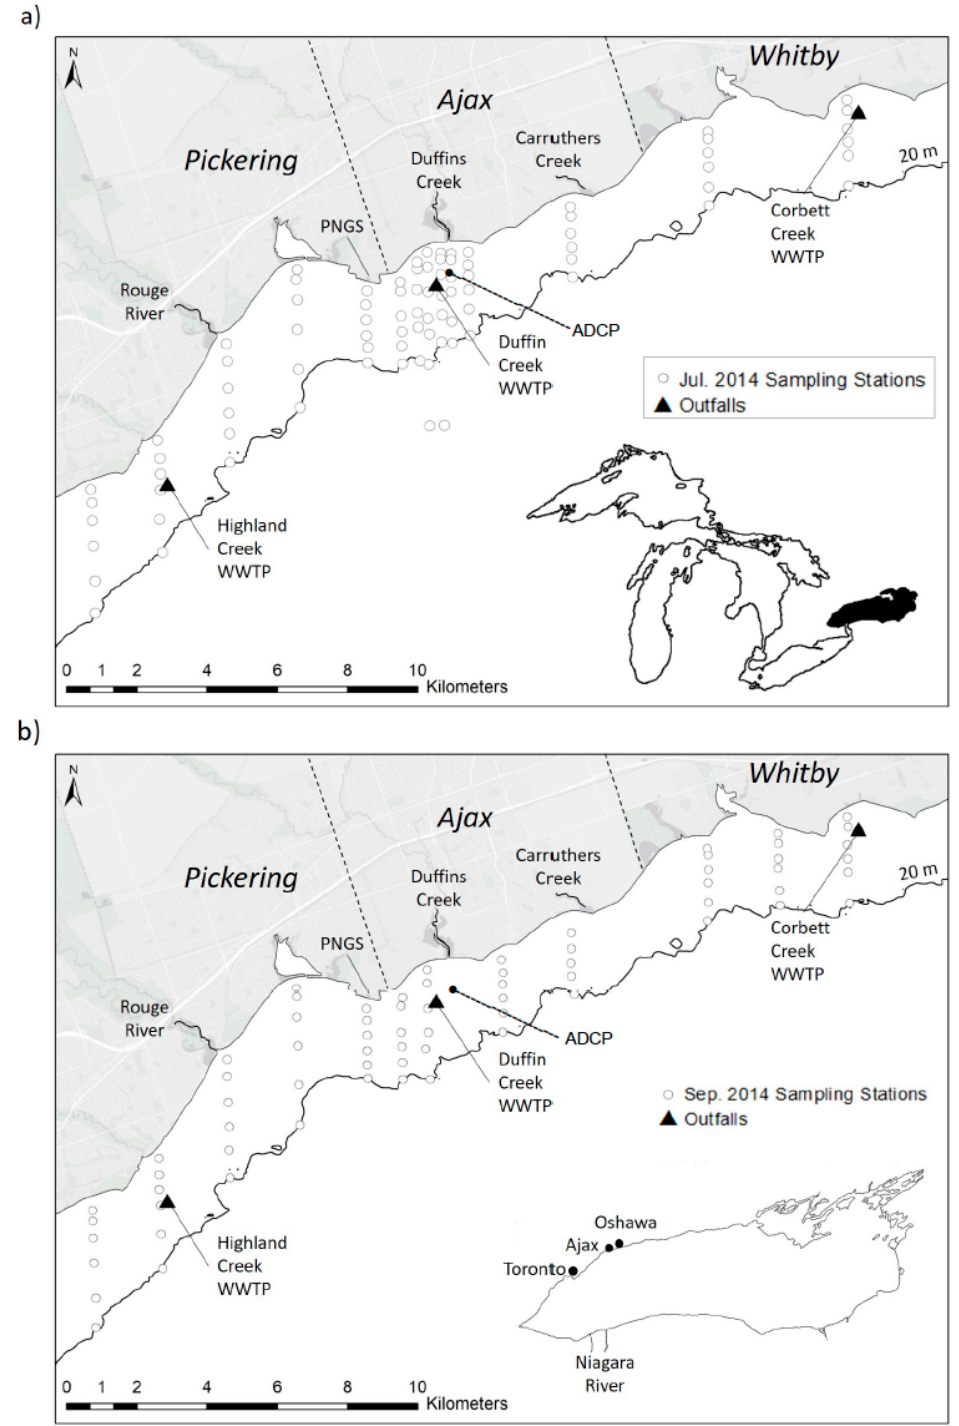
Figure 2. Lake Ontario study site with locations of point source and tributary discharges and sampling stations for July and September 2014 monitoring. Insets in panels ( a ) and ( b ) locate Lake Ontario on the Great Lakes and geographical locations cited in text, respectively.